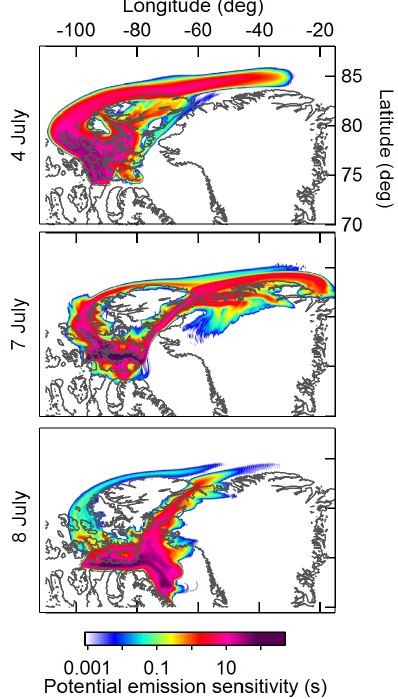
Figure 17. FLEXPART backward simulations of the considered measurement periods (Fig. 15) 3 days prior to sampling and at alti- tudes below 340m. The color-coded area presents values of the po- tential emission sensitivity (PES) function in a particular grid cell (Sect. 2.3). Different rows depict different measurement